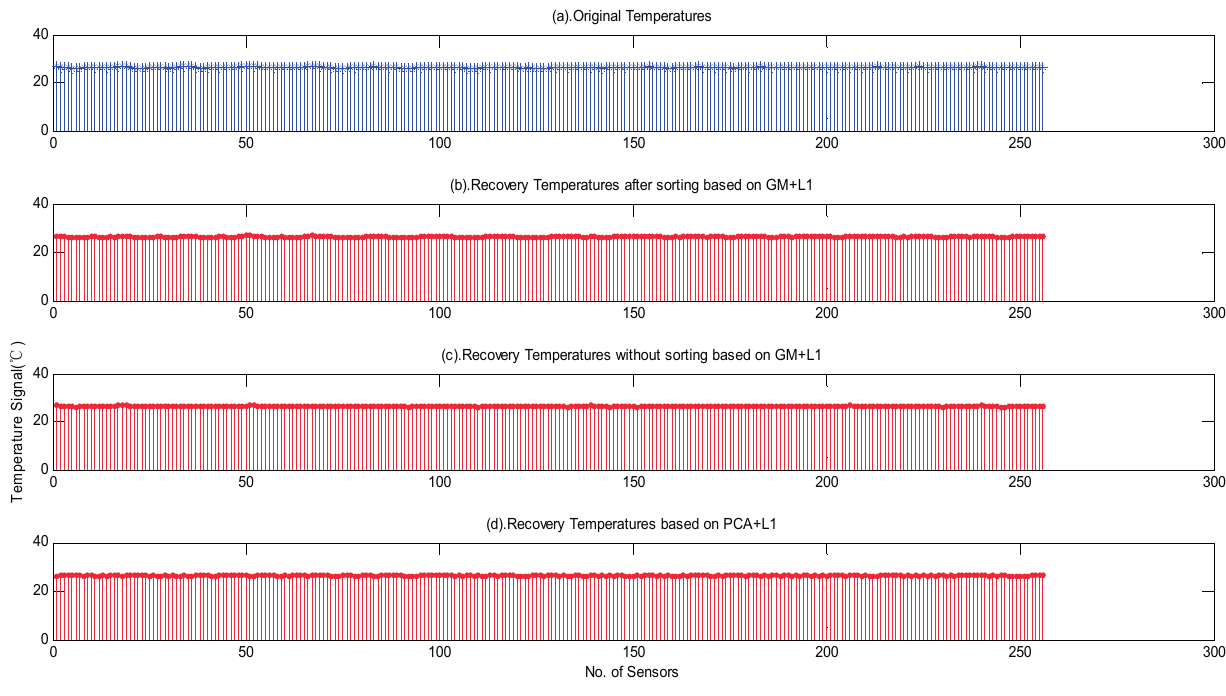
Figure 7. Effects of preprocessing for